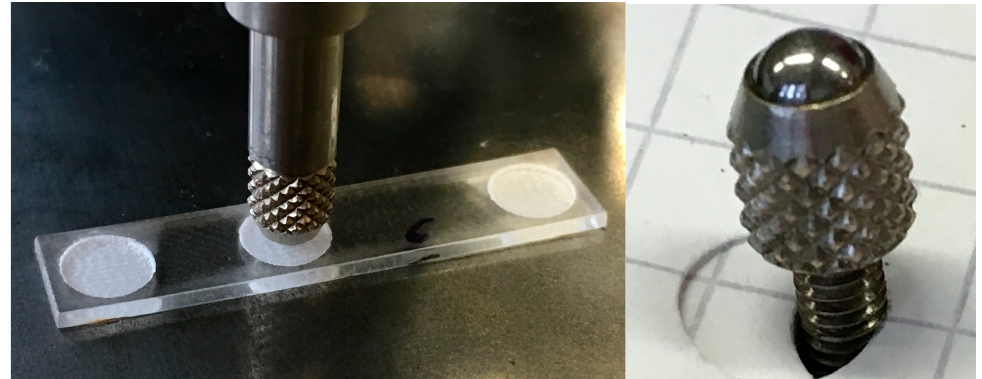
Figure 7. Determination of insulating layer’s thickness using a tactile measurement. Left : Measuring engraved acrylic glass, here an insulation layer is necessary on which the conductive silver can dry. Right: probe head in detail, the ball on the top has a diameter of approx. 3 mm.